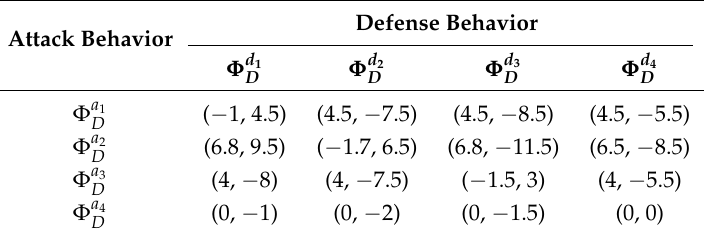
Table 7. Game matrix in disruption